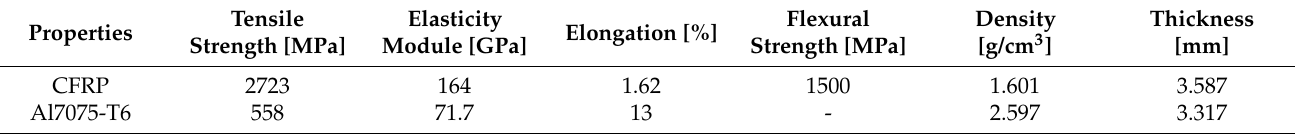
Table 1. Mechanical properties of CFRP and